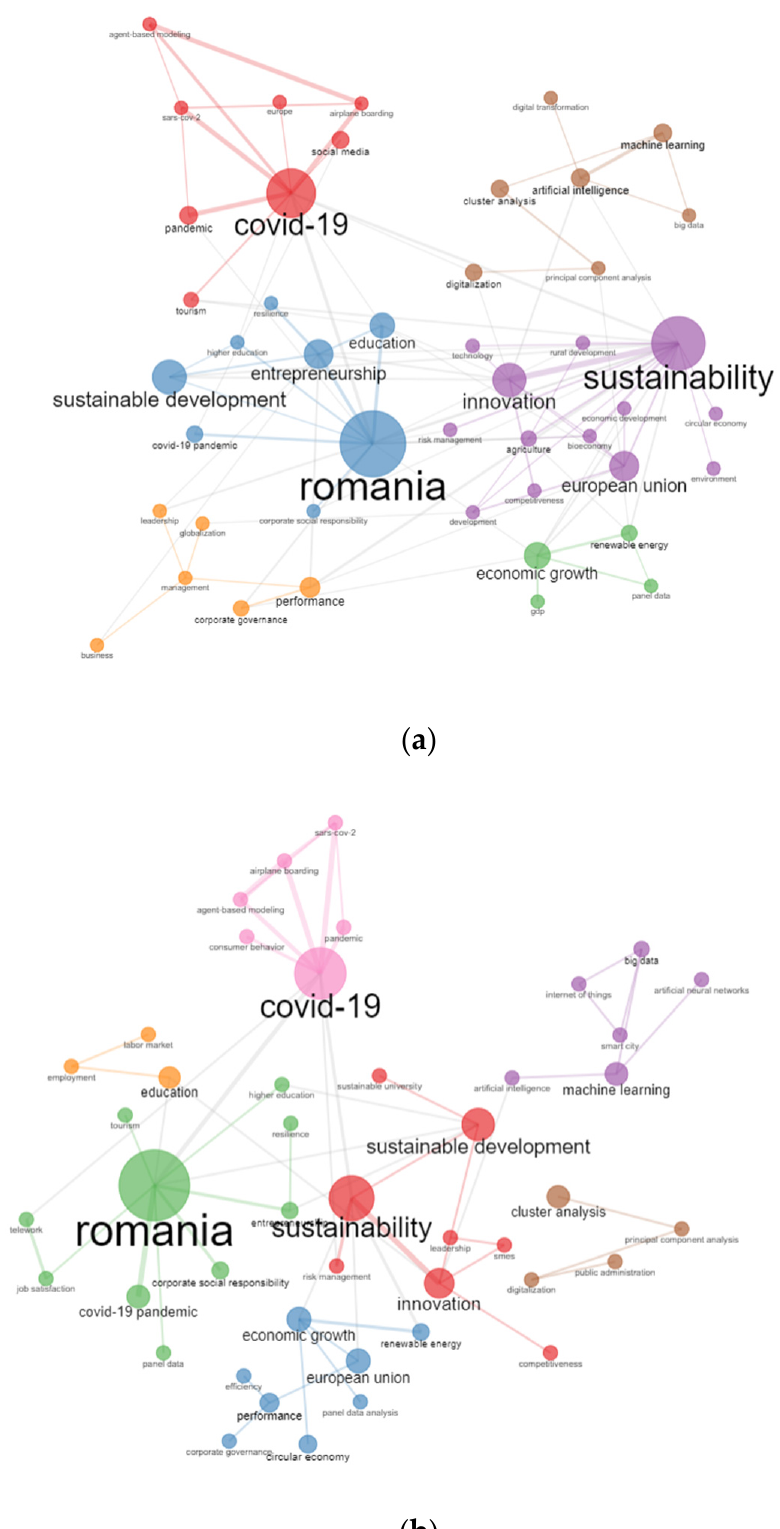
Figure 12. Cooccurrence network analysis on authors’ keywords. ( a ) WoS. ( b ) Scopus.